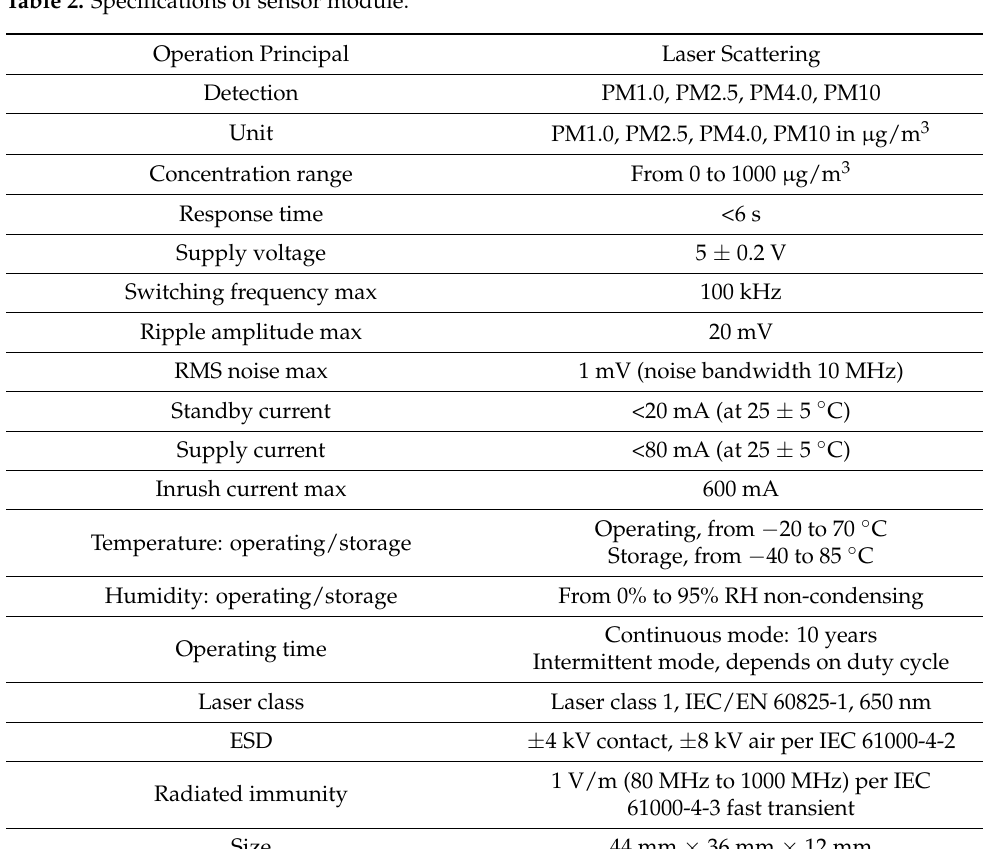
Table 2. Specifications of sensor